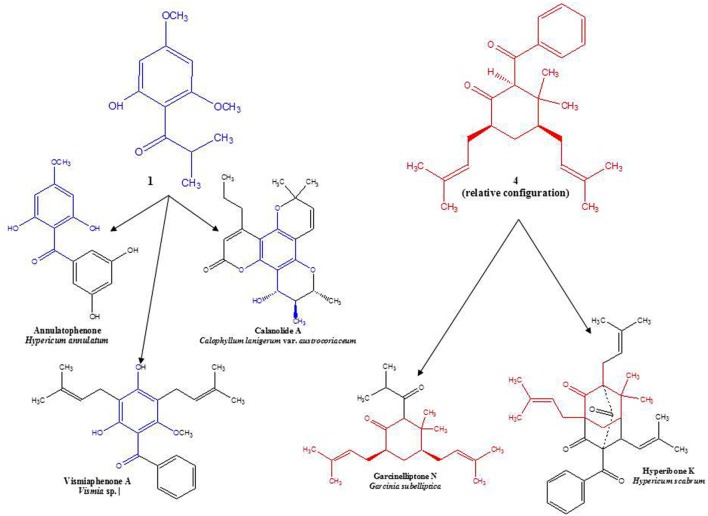
Examples of structural similarities between currently and previously isolated compounds from selected species of Hypericaceae, Calophyllaceae, and Clusiaceae (Delle Monache et al., 1980; Kitanov and Nedialkov, 2001; Tanaka et al., 2004; Weng et al., 2004).